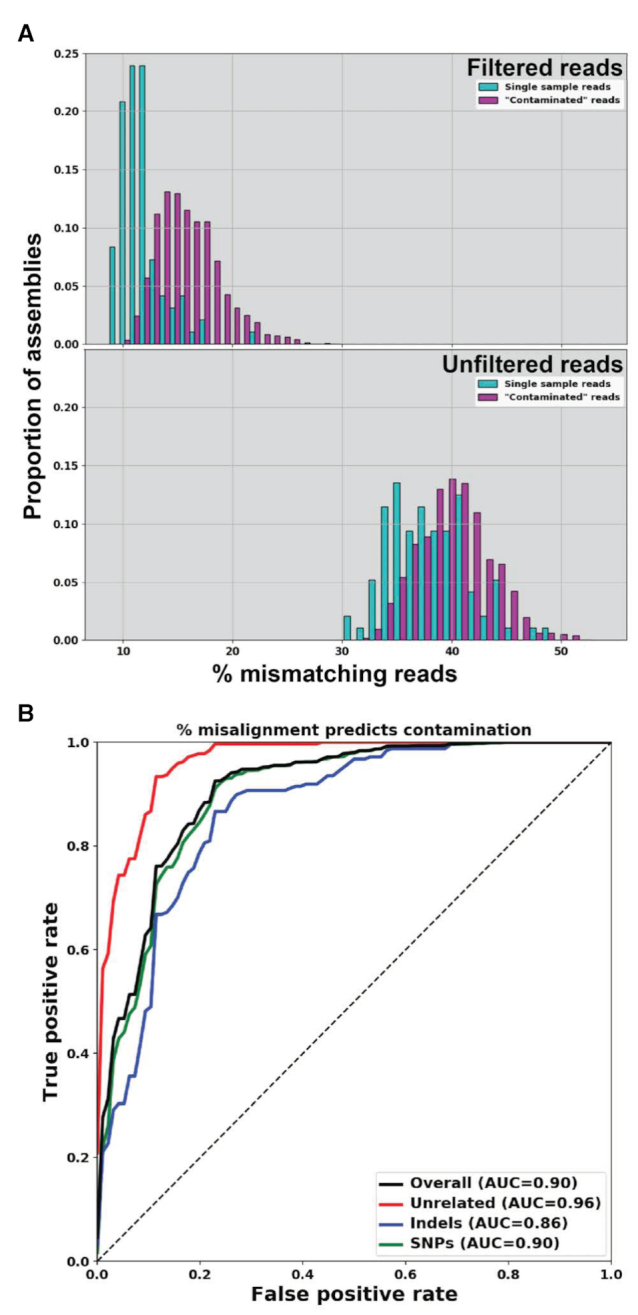
Misalignment of reads to the assembly can be used as a marker of contamination. (A) Input reads aligned back to their associated de novo assembly for contaminated and clean samples for filtered (top) and unfiltered (bottom) reads. (B) Receiver operating characteristic (ROC) curve demonstrating that, using the percent of mismatching reads alone, we can predict contamination with high accuracy. Here, true positives are assemblies correctly predicted as contaminated, and false positives are clean assemblies incorrectly predicted as contaminated. AUC: area under the curve.